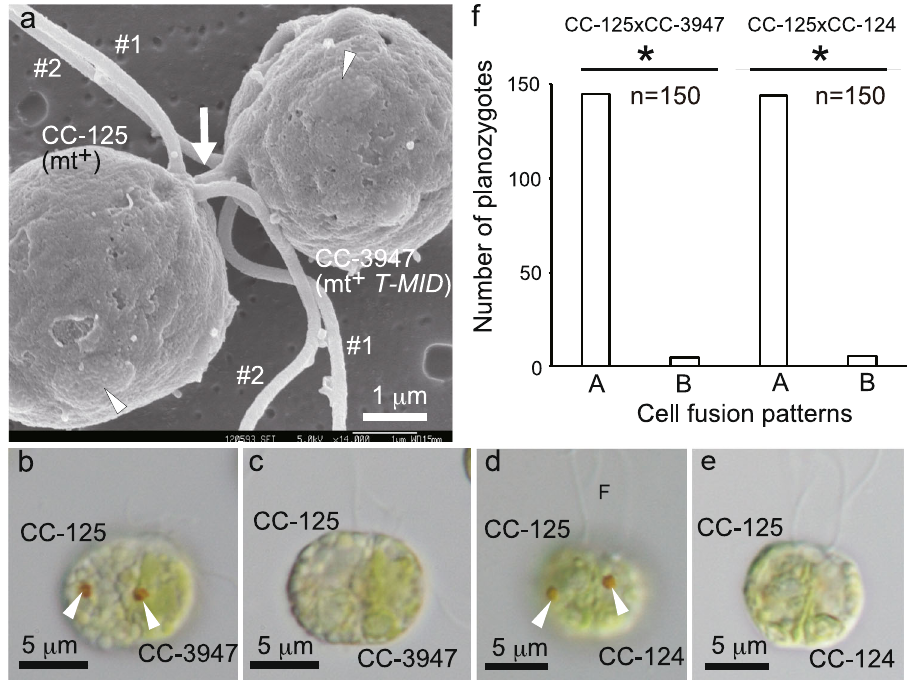
Fig. 4 Spatial positioning of the mating structure in the mating type-reversed strain CC-3947 (mt + T-MID ) gamete. a Positioning of the mating structure of the CC-3947 gamete observed by FE-SEM using mating gametes 15 min after mixing wild-type CC-125 (mt + ) and CC-3947 gametes. The fertilisation tubule elongated from the mt + mating structure fused to that of CC-3947, which was present on the same side of the beat plane as the eyespot. Arrow and arrowheads indicate the fertilisation tubule and eyespots, respectively. b , c Differential interference contrast images of the planozygote 15 min after mixing wild-type CC-125 (mt + ) and CC-3947 gametes. d , e Differential interference contrast images of the planozygote at 15 min after mixing wild-type CC-125 (mt + ) and CC-124 (mt – ) gametes. Images were focused on the upper ( b , d ) and lower ( c , e ) surface of the cell, respectively. f Number of planozygotes with two eyespots on the same side (A) or opposite side (B) of the cell at 15 – 30 min after mixing the gametes. Similar results were obtained from three independent experiments ( n = 150, 126, and 133 in CC-125 × CC-3947; n = 150, 358, and 465 in CC-125 × CC-124), and a representative result is shown. *Signi fi cant difference between (A) and (B) by the binomial test ( p < 0.01, parameter θ = 0.5). #1 : no. 1 fl agellum, #2 : no. 2 fl agellum, F : fl agellum.